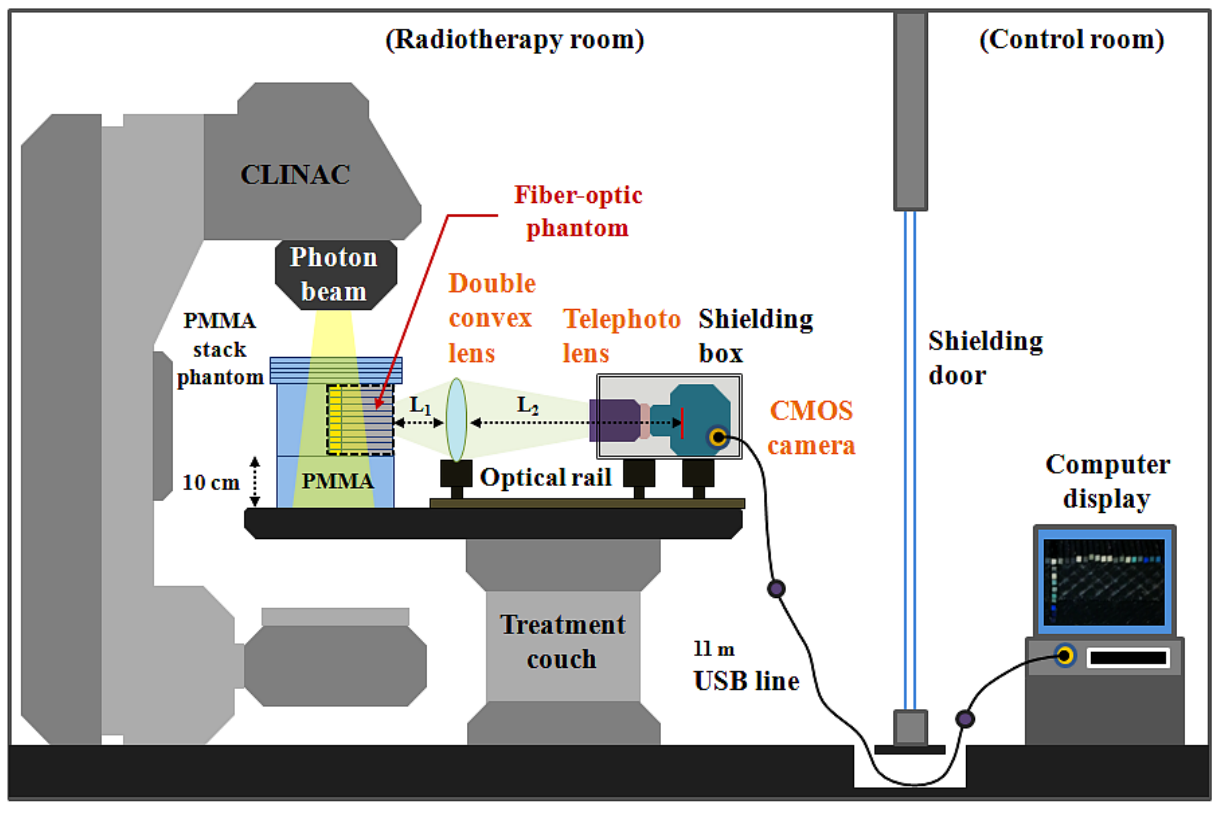
Figure 2. Experimental setup using the proposed T-shaped fiber-optic phantom-dosimeter